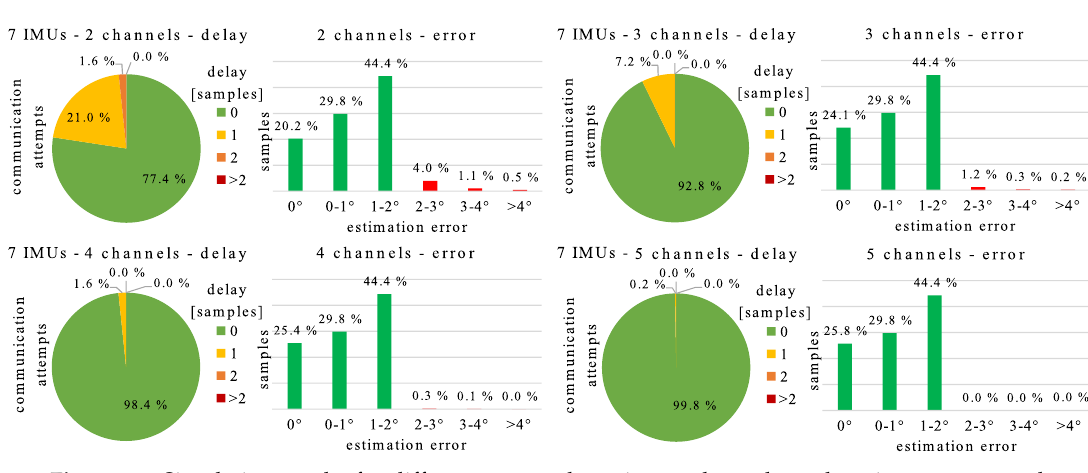
Figure 13. Simulation results for different assumed maximum channel numbers in a star network with seven inertial measurement units (IMUs) as senders. The pie charts show how often a sender can communicate immediately (delay 0) or must wait 1, 2, or more sampling instants until its communication attempt is successful. The bar charts show the distribution of the estimation error. We consider hierarchical ETL and 4 min of variable